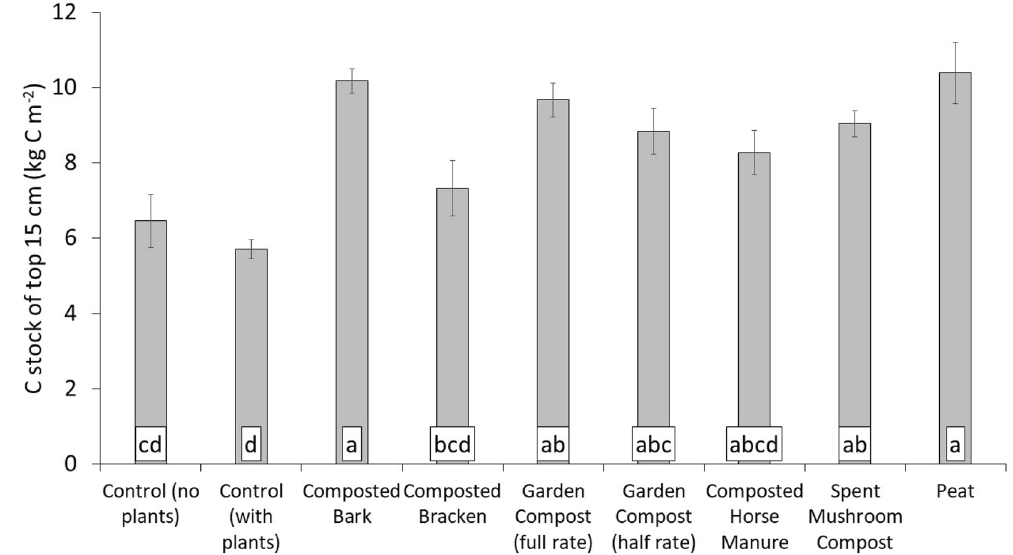
Figure 3. Soil C stock of the top 15 cm of amended soil after six annual applications (Year 6). Mean of eight replicate experimental plots in Year 6 (n = 8). Error bars for standard error. Treatments that share a lower-case letter label have no significant difference according to one-way ANOVA and Tukeys post-hoc testing ( p >